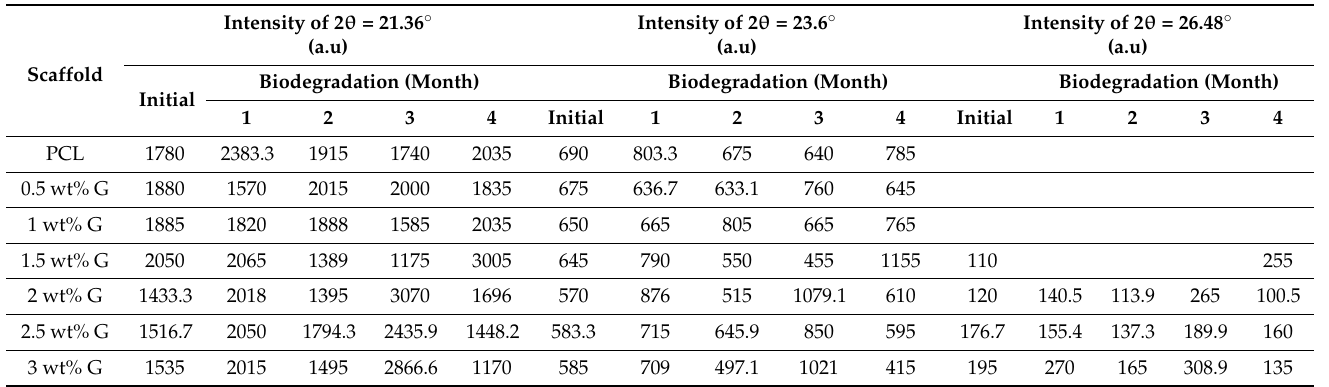
Table 2. X-ray diffraction intensity of 2 θ = 21.36 ◦ , 2 θ = 23.6 ◦ , and 2 θ = 26.48 ◦ of PCL/G scaffold over 4